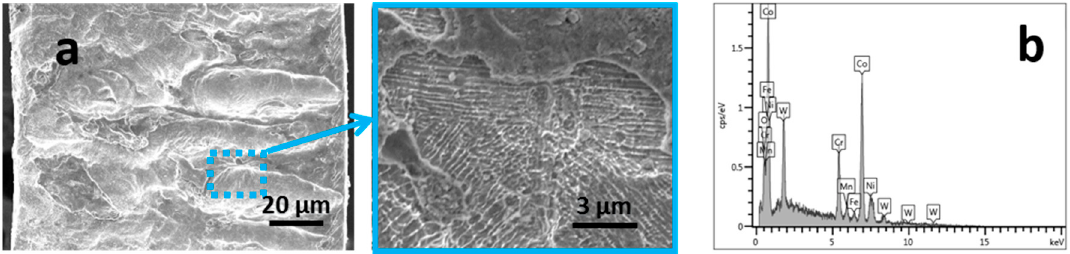
Figure 4. ( a ) The image of the oxygen cuts with acid pickling; ( b ) energy dispersion spectrum (EDS).